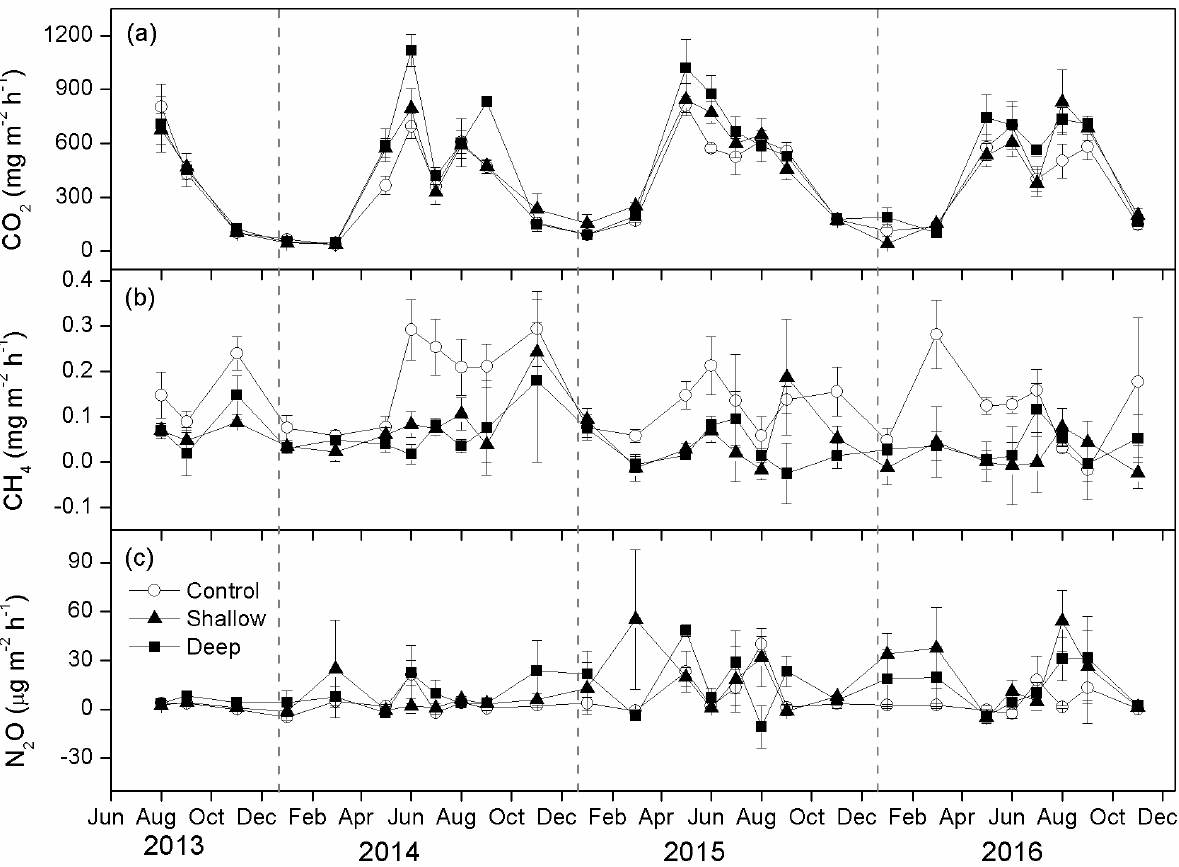
Figure 4. Monthly emission rates of (a) carbon dioxide (CO (N O) for the control, shallow and deep water table treatments during the experiment. Error bars represent 2 ±1 Standard